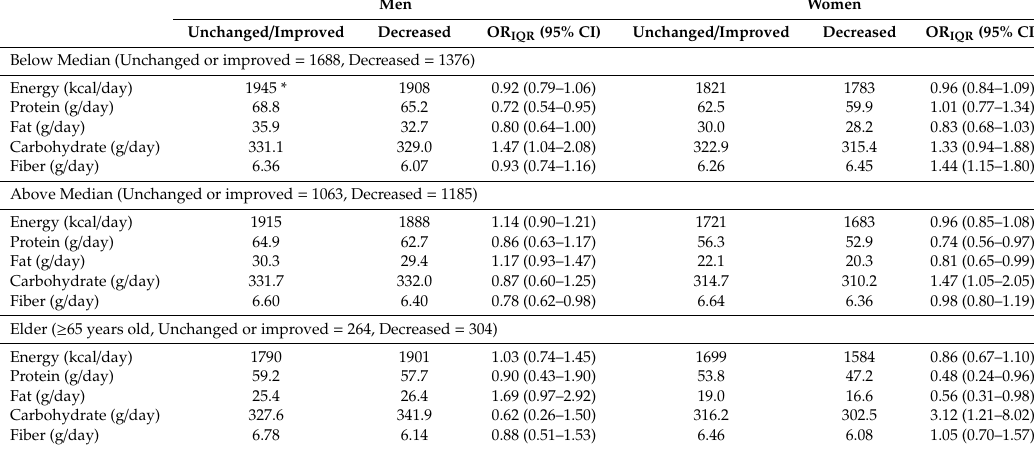
Table3. Theassociationbetweenmacronutrientintakeandthelungfunctionbymedianage(50yearsold) and among elderly